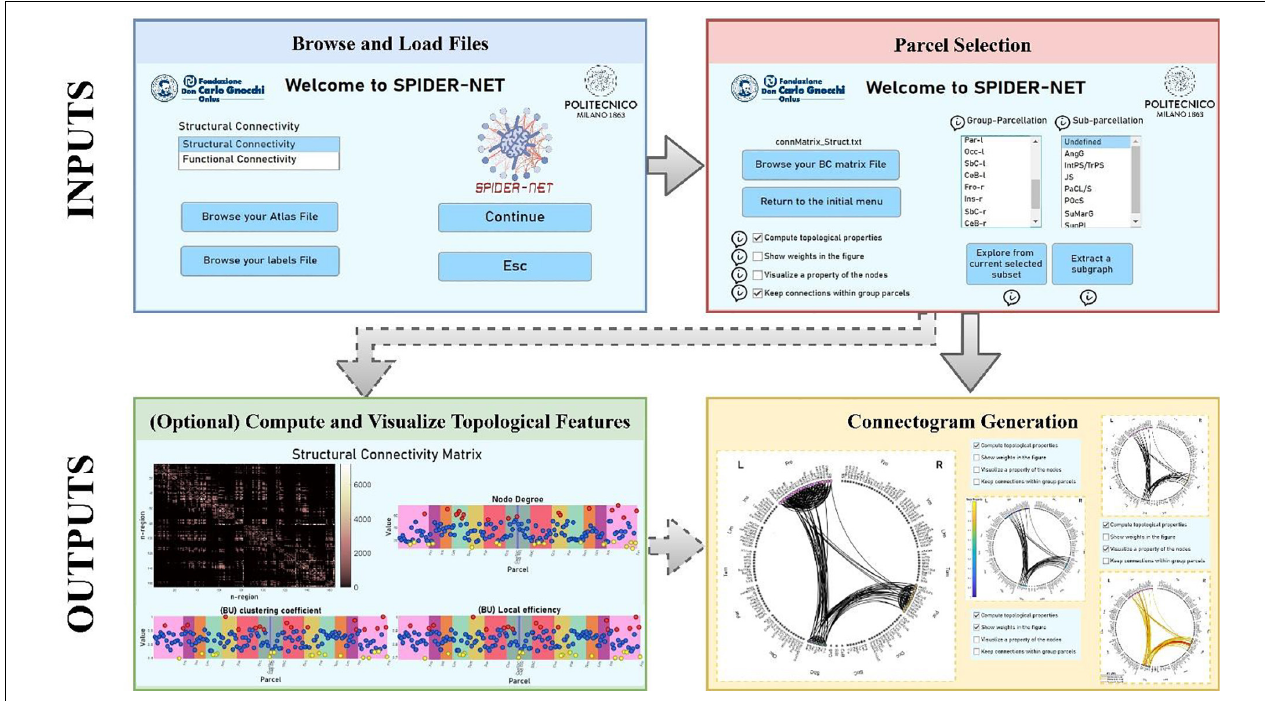
FIGURE 1 | Flowchart for SPIDER-NET usage. First, the Atlas and Label input files are browsed and loaded (blue box). Then, the Connectivity Matrix file is loaded and the selection of the sub-network of interest is performed (red box). Optionally (dashed lines), it is possible to compute and visualize topological properties of the selected brain network (green box). Finally, the connectogram is generated according to the selection made and to the chosen visualization settings (yellow